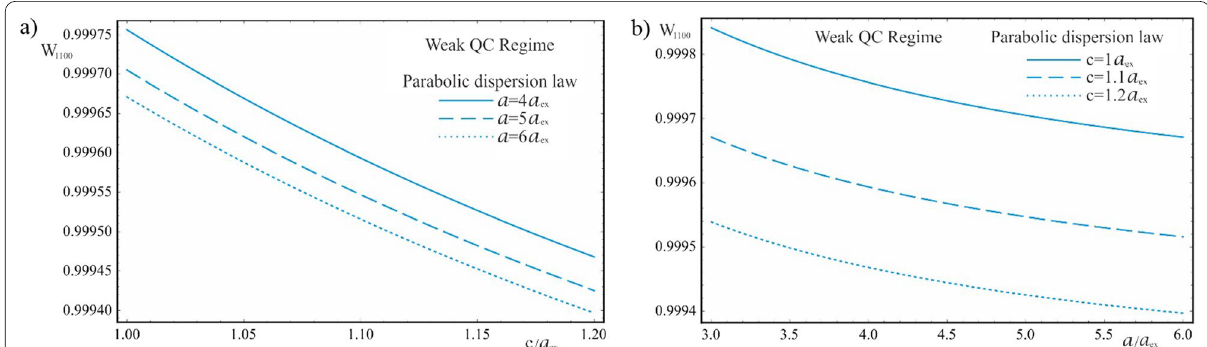
Fig. 13 The dependences of the AE for the parabolic dispersion law of CCs in the weak quantum confinement regime: ( a ) on the minor semiaxis c at the different values of the major semiaxis a , ( b ) on the major semiaxis a at the different values of the minor semiaxis